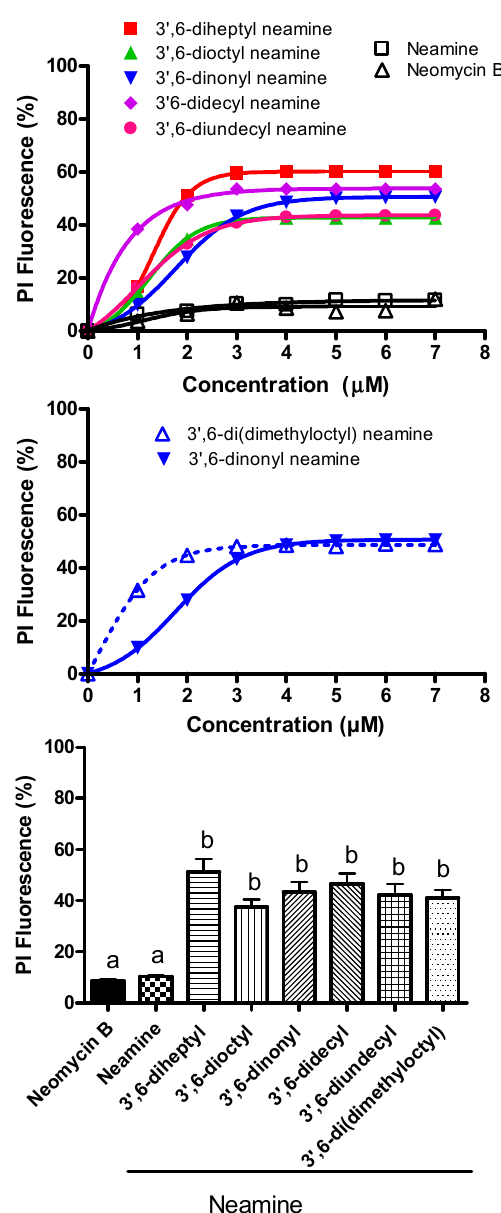
Figure 6. Effect of 3’,6-dialkyl neamine derivatives on P. aeruginosa permeability assessed by the increase in the fluorescence of propidium iodide. (Top) 3’,6-diheptyl neamine ( (cid:4) ), 3’,6-dioctyl neamine ( (cid:78) ), 3’,6-dinonyl neamine ( (cid:72) ), and 3’,6-didecyl neamine ( (cid:7) ), 3’,6-diundecyl neamine( • ), neamine ( (cid:3) ), neomycin B ( ∆ ), (Middle) 3’,6-dinonyl neamine ( (cid:72) ), and 3’,6-di(dimethyloctyl) neamine ( ∆ ). Dose-dependent membrane permeability expressed as a percentage of the maximal value recorded in the presence of 50 µ M Colistin, used as a positive control. Error bars are omitted for the sake of clarity (SEM ≈ 4%). (Bottom) propidium fluorescence for 3’, 6-dialkyl Neamine derivatives at 5 µ M. Statistical assays were one-way ANOVA’s analysis with Tukey’s multiple comparison test. In each group, bars with different letters indicate significant differences ( p <